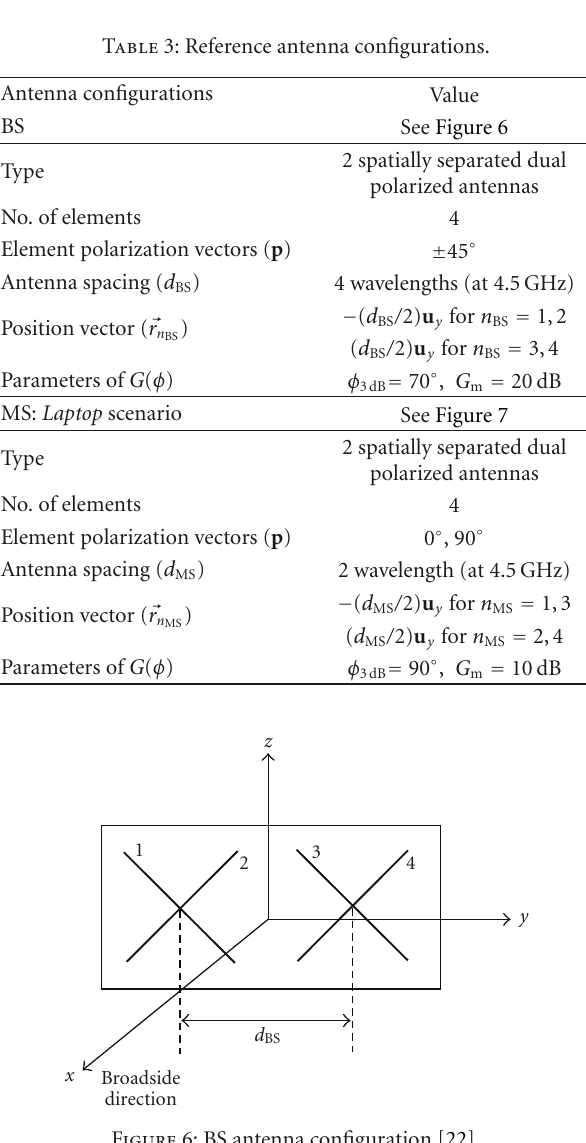
Figure 6: BS antenna configuration [22].